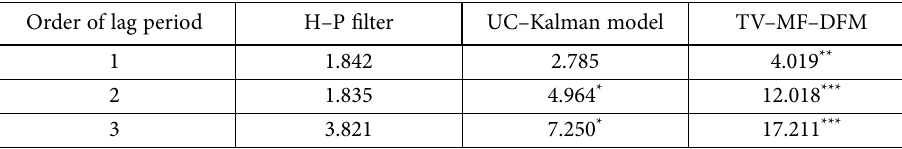
Table 4. Estimation results of time-varying Granger causality test Order of lag